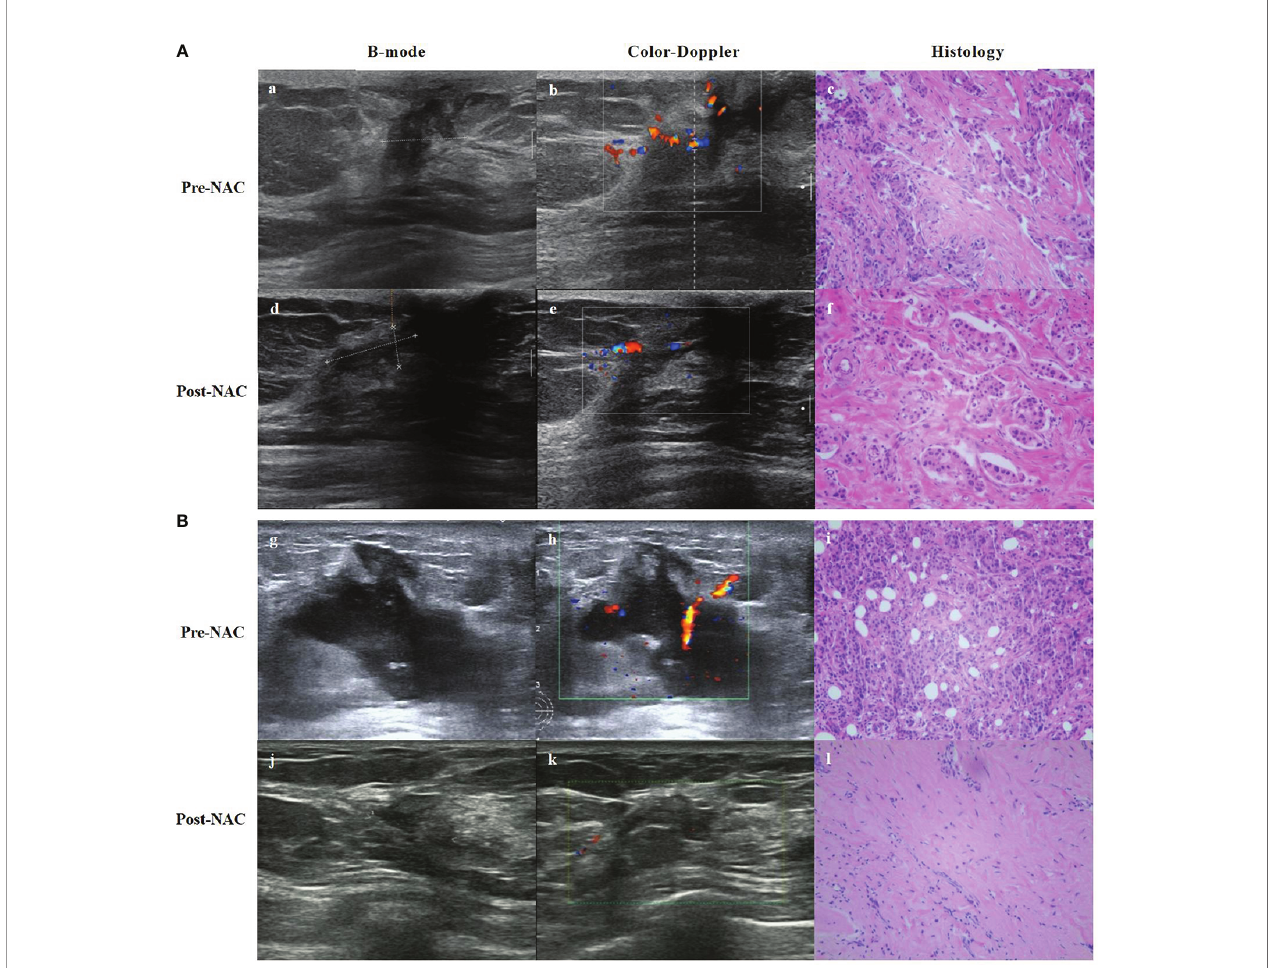
FIGURE 3 | B-mode, Color-Doppler ultrasound and histology from a partial responder (A) and complete responder (B) before start of NAC (Pre-) and after 8 course of NAC (Post-). (A) (a) B-mode ultrasound: the tumor was hypoechoic. (b) Color-Doppler ultrasound: moderate peripheral vascular signals. (c) Microscopic image of core-needle biopsy. After 8 course of NAC. (d) B-mode ultrasound: the echogenicity increased. (e) Color-Doppler ultrasound: less residual vascularization compared to baseline. (f) Microscopic image after NAC shows residual tumor cells, but reduced compared to baseline. (B) (g) B-mode ultrasound: the tumor was hypoechoic. (h) Color-Doppler ultrasound: moderate intralesional and perilesional vascularization. (i) Microscopic image of core-needle biopsy. After 8 course of NAC. (j) B-mode ultrasound: the echogenicity increased and tumor volume decreased. (k) Color-Doppler ultrasound: almost no vascular spots. (l) Microscopic image after NAC presents visible stromal tissue, no visible tumor